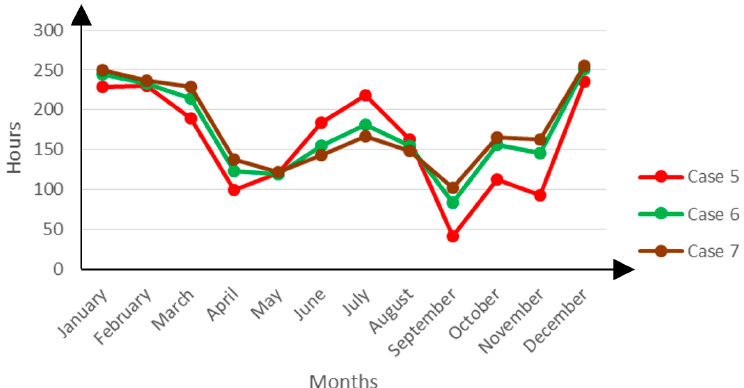
Figure 10. Discomfort hours for Cases 5, 6 and 7.